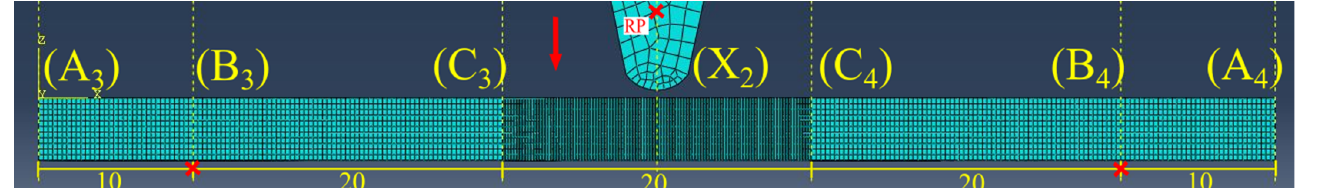
Figure 6. The modelled IT sample with boundary conditions and loads.